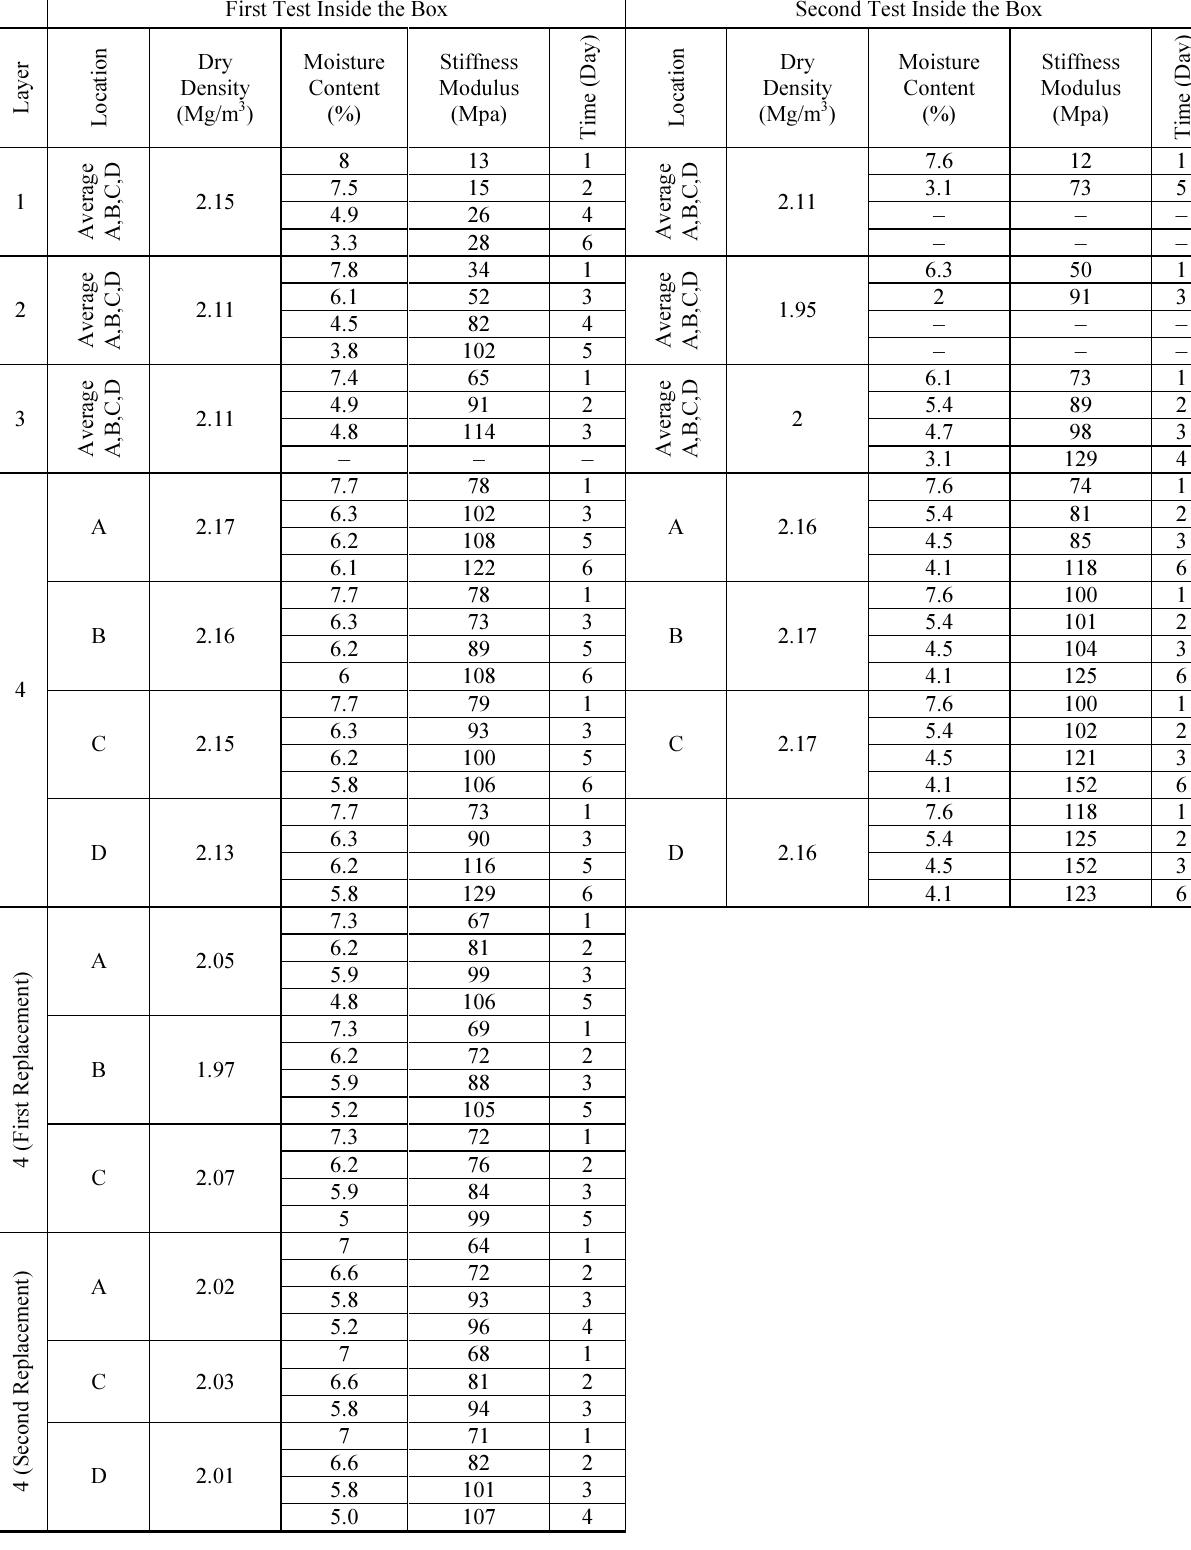
Table 1. Summary of laboratory